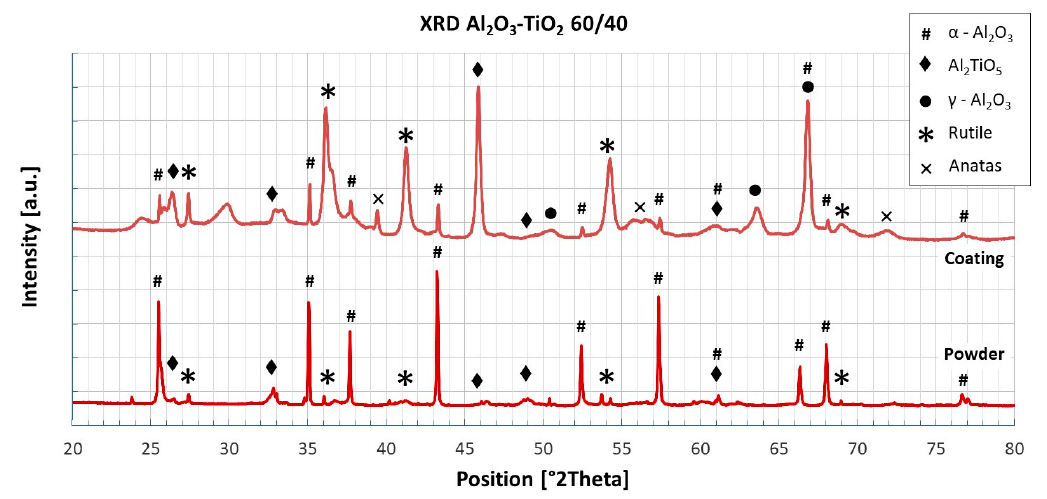
Figure 10. XRD patterns of the as-sprayed APS Al 2 O 3 /TiO 2 60/40 coating (upper) and spray powder (lower).